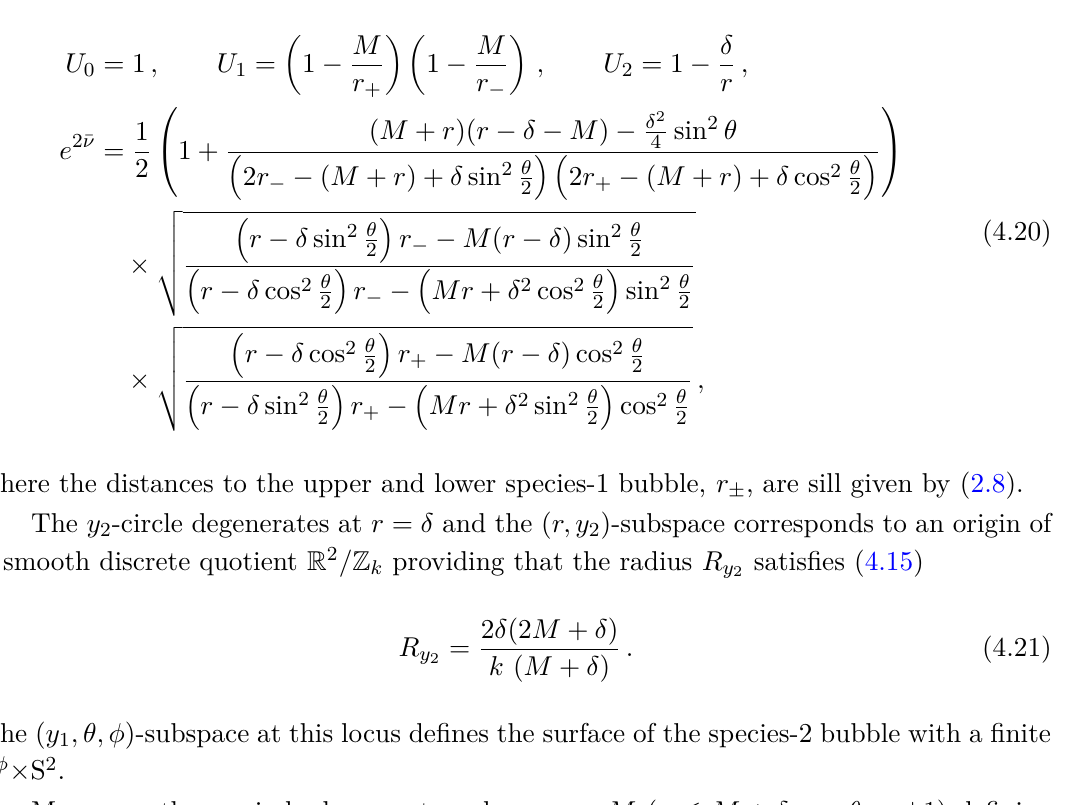
From the generic expressions (4.6) with the rod configuration considered, we